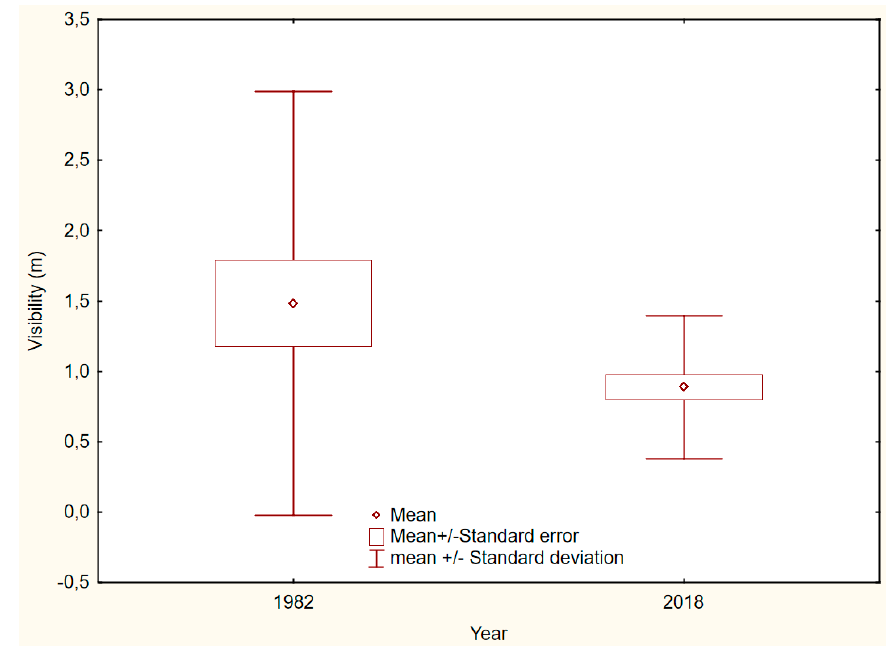
Figure 8. Mean annual (1982 and 2018) values of the Secchi disc visibility (±SD) in the water of Miłkowskie Lake. Table 4. Classification of water trophies of Mi ł kowskie Lake based on the 2018 results (OECD 1982).